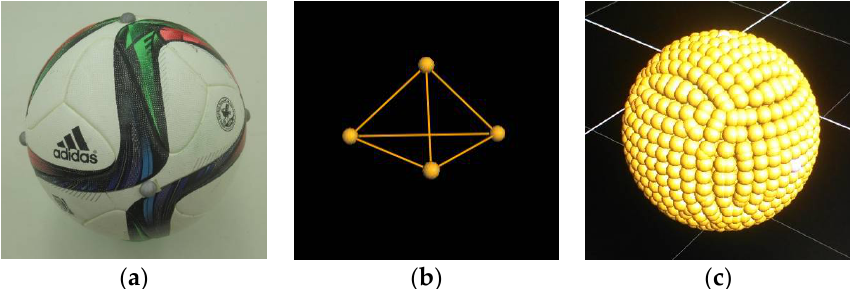
Figure 1. The surface model of ball was made from captured real 4 markers: ( a ) Real 4 markers on ball (top, front, right and left); ( b ) Captured real 4 markers; ( c ) Virtual markers were located in surface by fixing radius from center of ball as the midpoint of right and left